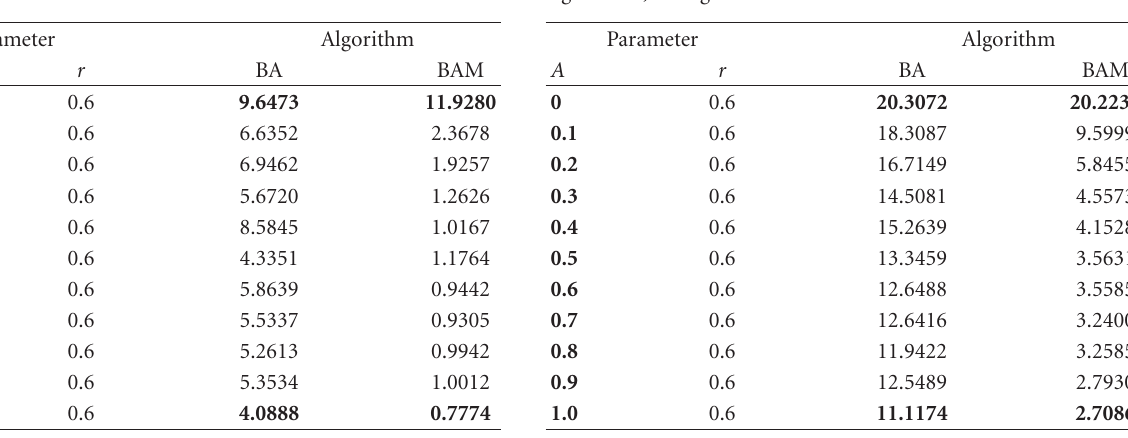
Table 10: Best normalized optimization results on UCAV path planning problem on di ff erent A . The numbers shown are the best results found after 100 Monte Carlo simulations of BA and BAM algorithms.